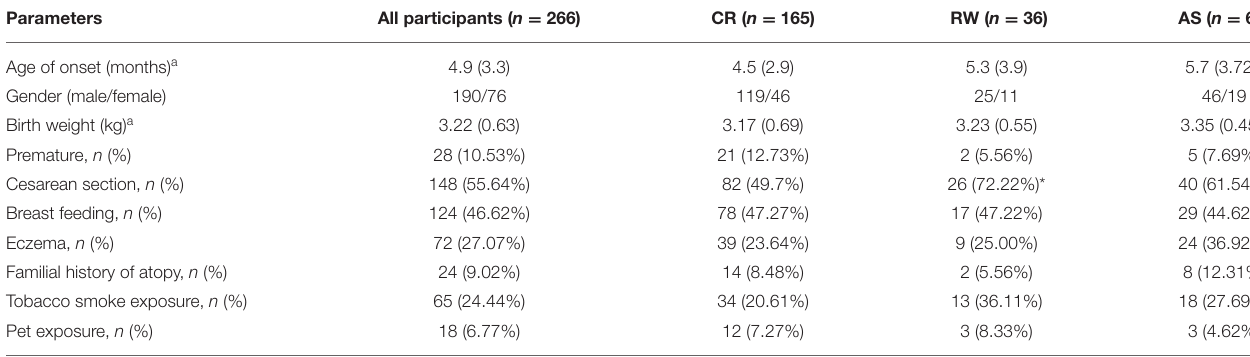
TABLE 1 | Demographic data of patients with RSV bronchiolitis among three groups. Parameters